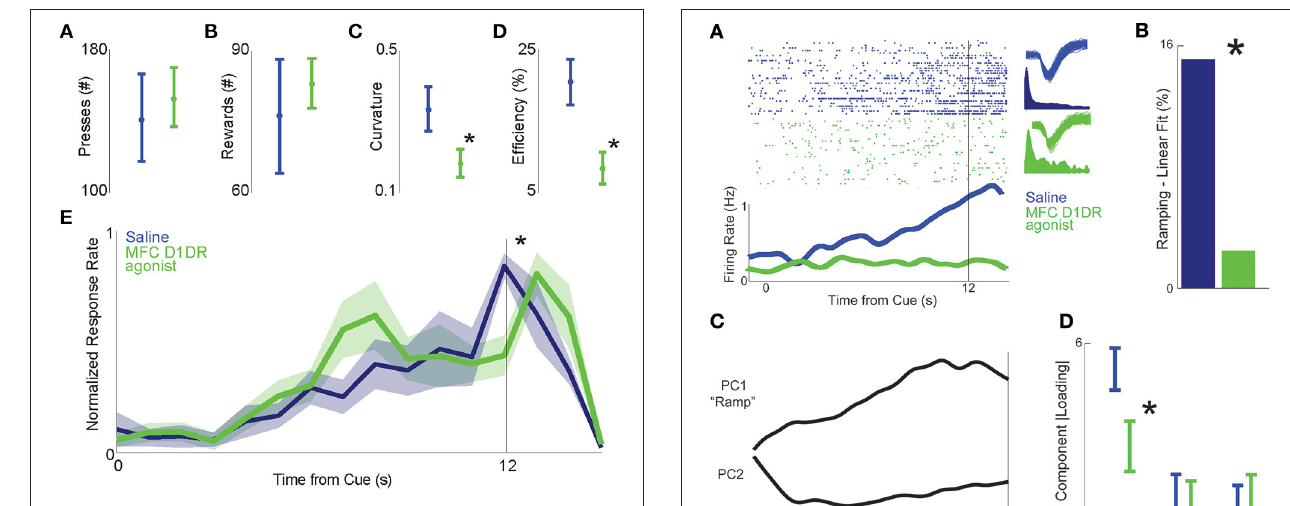
FIGURE 2 | Focal infusion of MFC D1 agonist into the MFC decreases the efficiency of interval timing without changing other aspects of behavior. MFC D1DR agonists (green) did not change the number of overall lever presses (A) or the number of rewards (B) when compared to saline sessions (blue). (C) Curvature indices of time-response histograms we significantly reduced in MFC D1DR agonist sessions compared to control sessions, and (D) MFC D1DR agonist decreased how efficiently animals timed. (E) Time-response histograms during interval timing sessions show less accurately timed lever pressing in animals following infusion of MFC D1DR agonist (in 7 animals). Asterisks represent significance at p < 0.05 via a t -test. MFC SKF82958 infusion did not change overall firing rate (2.9 ±